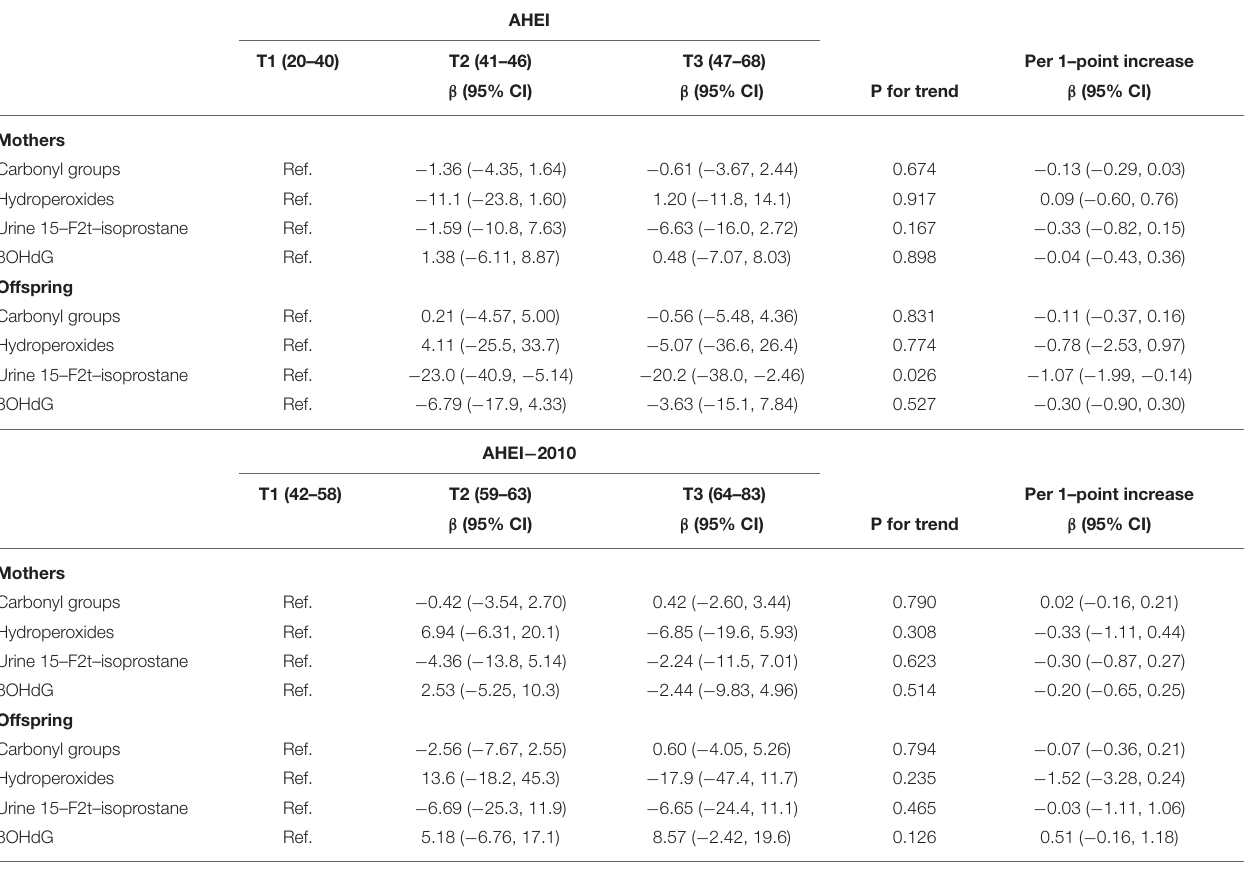
TABLE 5 | Associations between maternal Alternate Healthy Index (AHEI) and AHEI-2010 indices in the pregnancy and biomarkers of oxidative stress in mothers and their offspring. The NELA study.